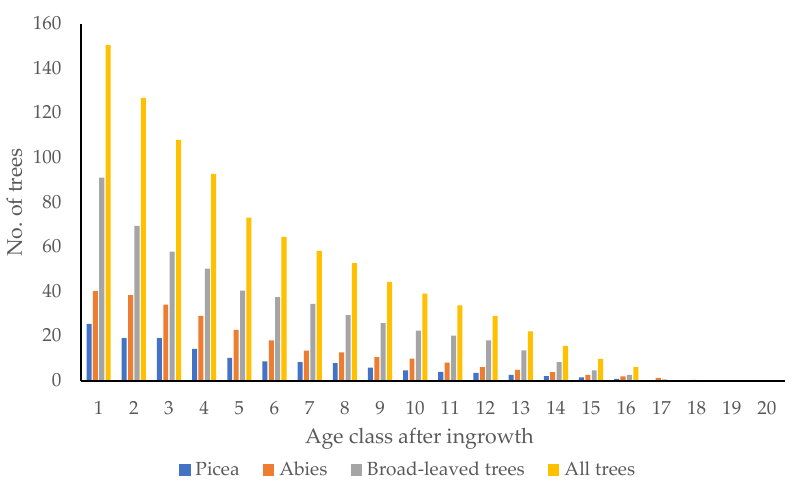
leaved trees; the rest of the periods are attached to the appendix section. Figure 6 shows the climax state of conifer and broad ‐ leaved trees based on the gen ‐ eralized normal forest theory. The upper limit of age classes was determined based on the mean biological age [36] of the stand. The tree composition of conifer and broad ‐ leaved trees was in a stable state with an exponential shape of the climax state of the stand. The tree species composition along the age classes became closer and reached a mature state.